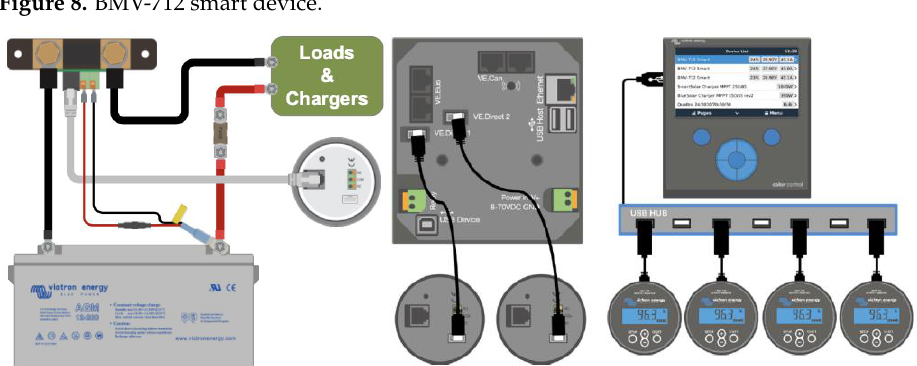
Figure 8. BMV-712 smart device.